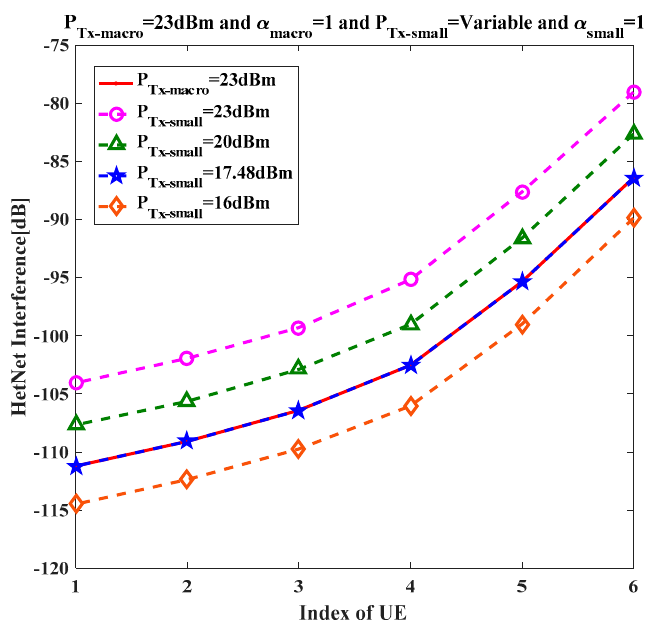
Figure11. Interferencecomparisonasafunctionof P max intheuniformmacrocellandHetNetdeployments. Electronics 2019 , 8 , x FOR PEER REVIEW Figure 11. Interference comparison as a function of P max in the uniform macro cell and HetNet deployments.